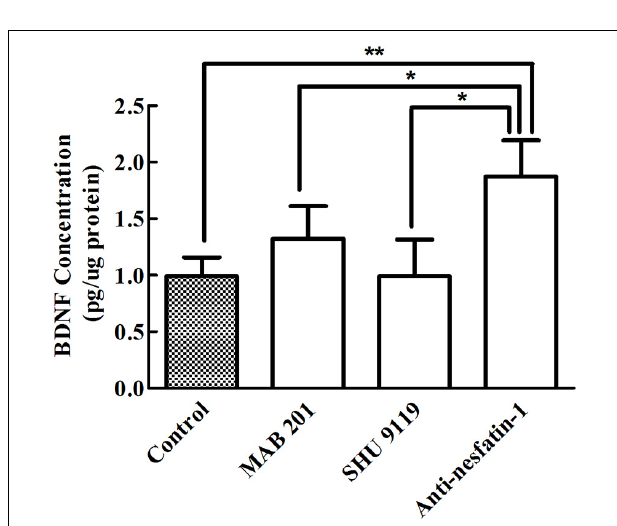
FIGURE 8 | Anti-nesfatin-1 antibody treatment elevated BDNF levels in the SNpc ( n = 6). Statistical analysis of BDNF protein levels in control mice and mice treated with MAB 201, SHU 9119 or anti-nesfatin-1 antibody. Each value represents the mean ± SD, n = 6; ** p < 0.005 and * p < 0.05. BDNF, brain-derived neurotrophic factor; MAB 201, non-immune anti-mouse IgG antibody; SHU 9119, MC4R receptor inhibitor; SNpc, substantia nigra pars